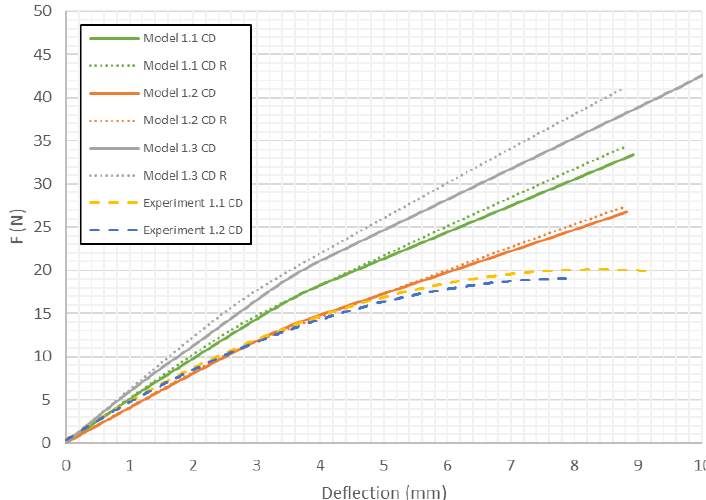
Figure 9. Deflection vs. force for Model 1 in CD.